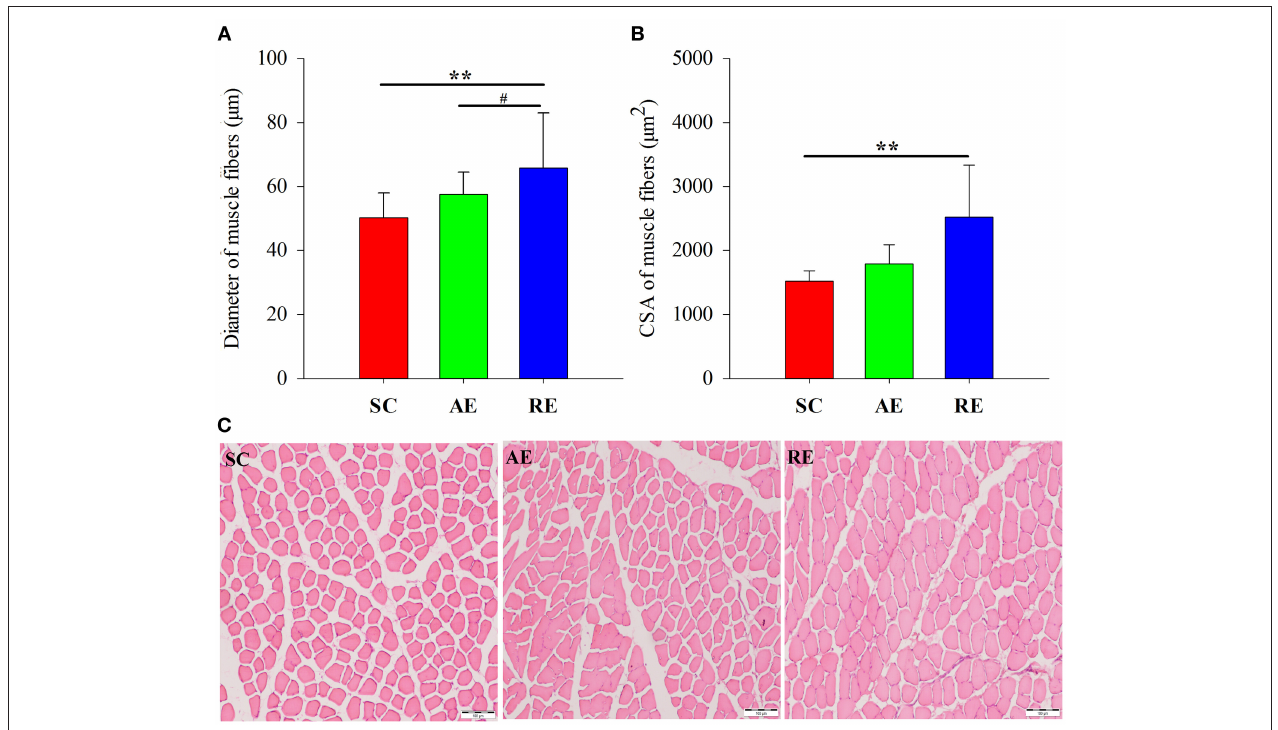
FIGURE 1 | Effects of exercise on (A) cross-sectional area (CSA), (B) diameter and (C) hematoxylin-eosin stained sections of gastrocnemius muscle in rats. Magnification 100 × , scale bars = 100 µ m. Values are provided as mean ± standard deviation for each group. SC, sedentary control group; AE: aerobic exercise training group; RE, resistance training exercise group. ** P < 0.01 vs. the SC group; # P < 0.05 vs. the AE group.